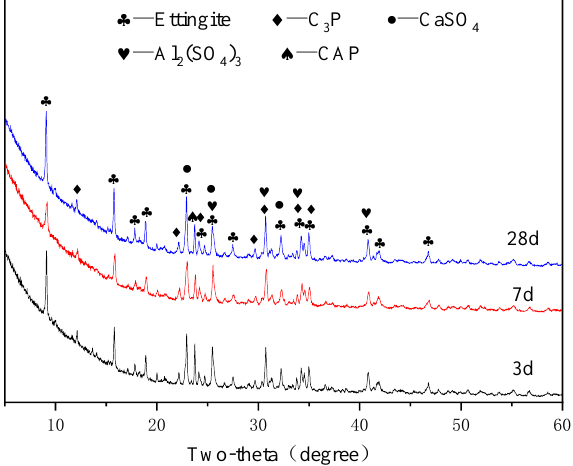
Figure 8. XRD patterns of APC paste for G3 group at different ages.